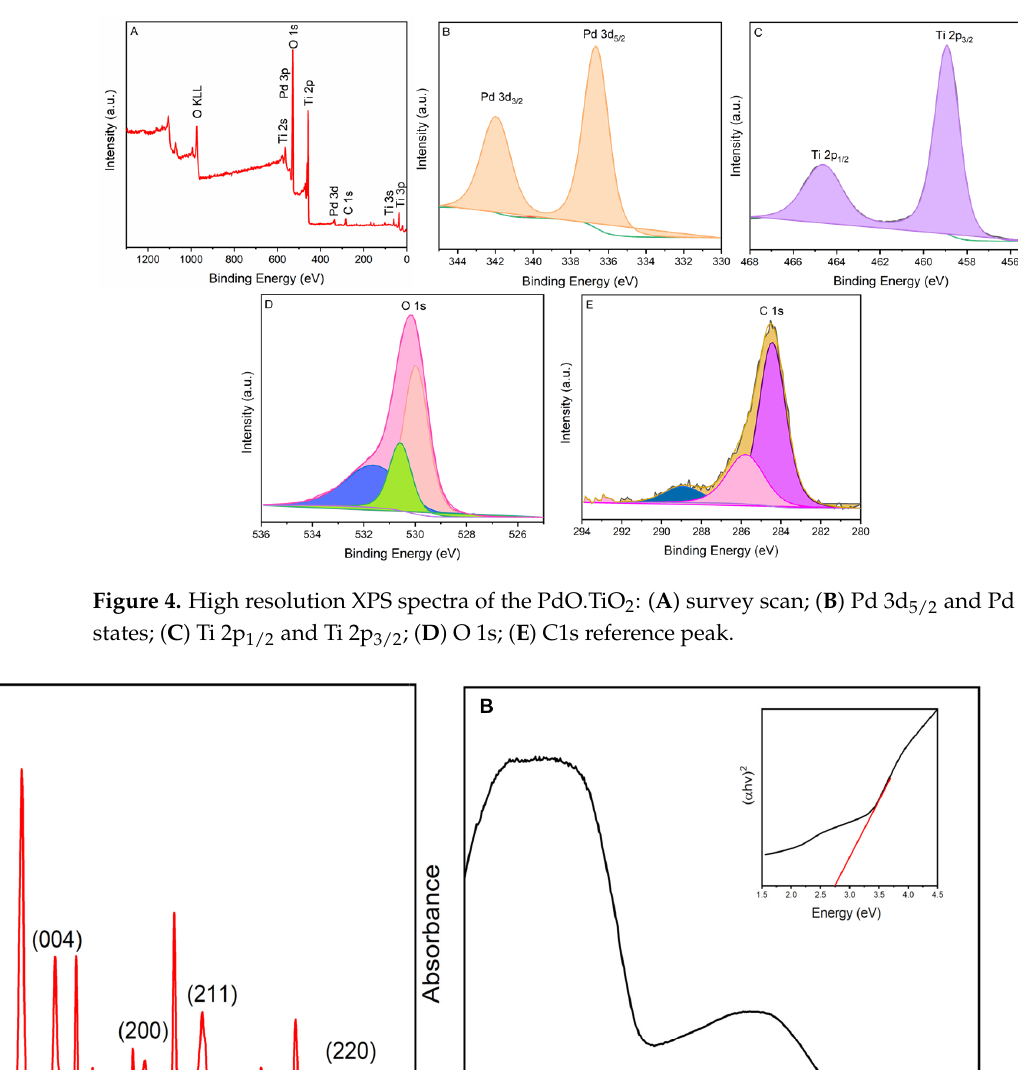
Figure 4. High resolution XPS spectra of the PdOTiO 2 : ( A ) survey scan; ( B ) Pd 3d 5/2 and Pd 3d 3/2 states; ( C ) Ti 2p 1/2 and Ti 2p 3/2 ; ( D ) O 1s; ( E ) C1s reference peak.